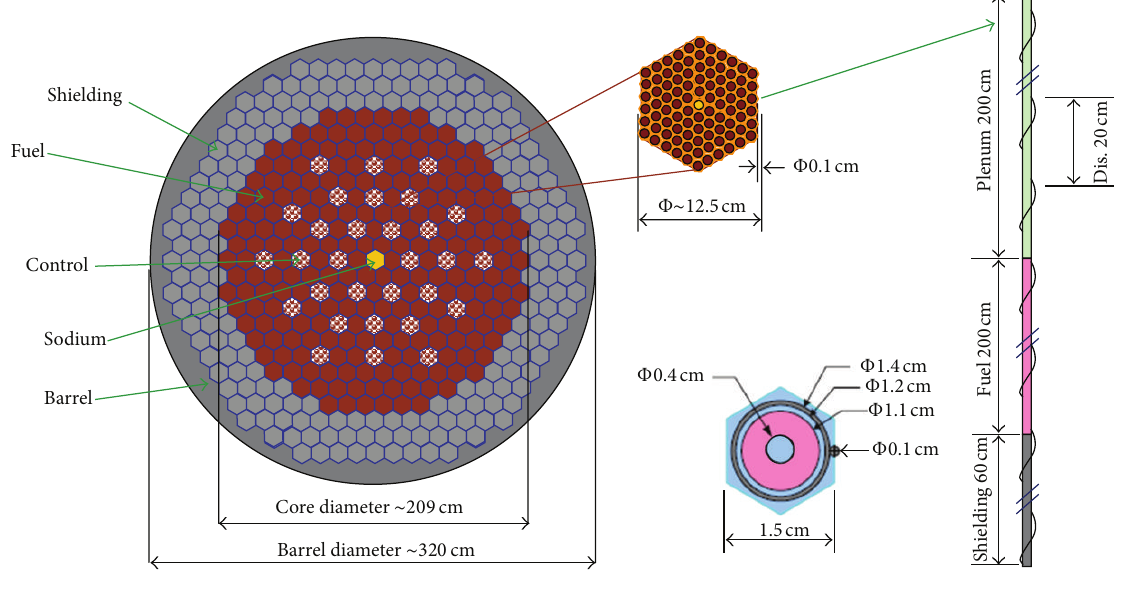
Figure 5: Schematic for the reference core of in situ breeding and burning reactor.